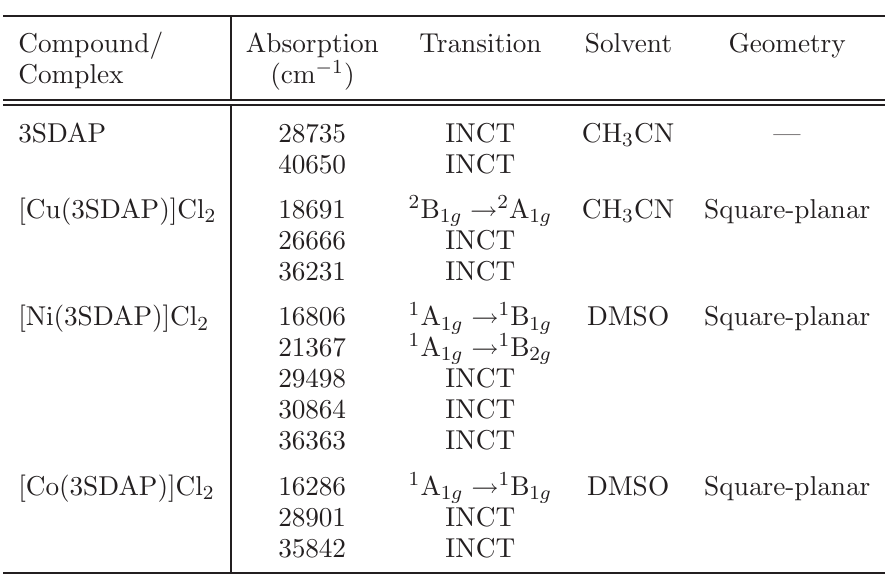
Table 3 Electronic absorption spectra of the synthesized